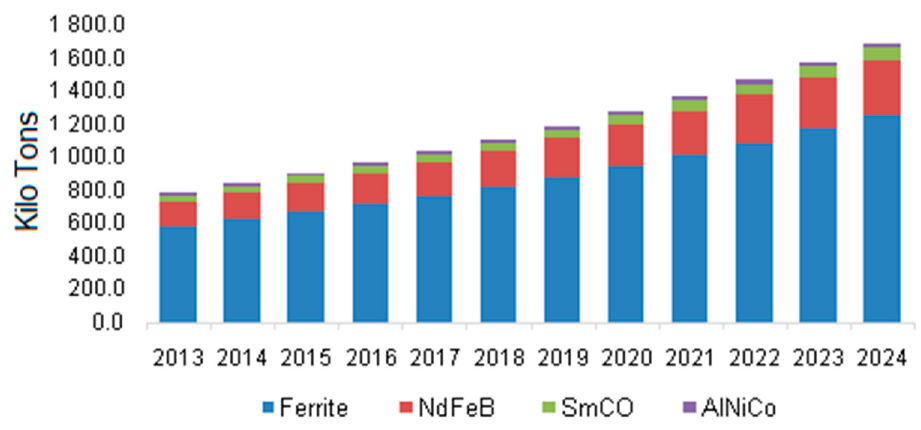
Figure 2. Global permanent magnet (PM) materials market capacity, 2013–2024 [9] .